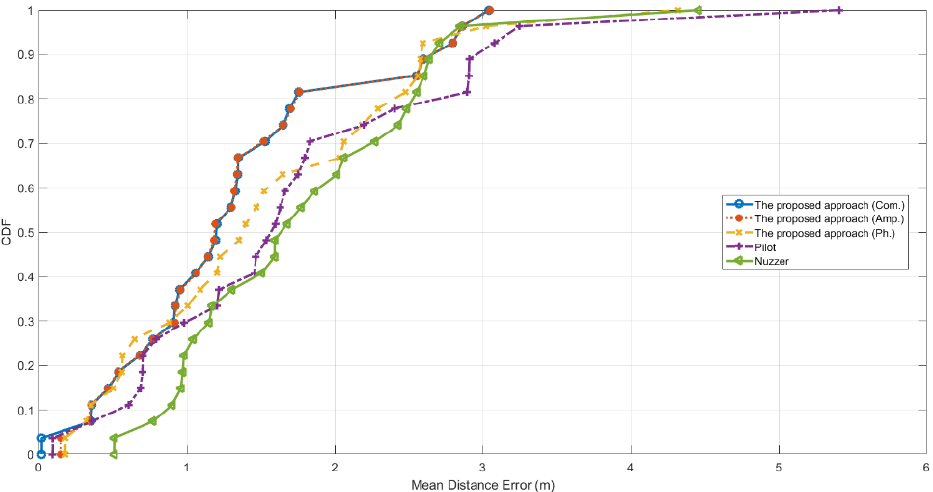
Figure 14. CDF of the mean distance error tested in the laboratory